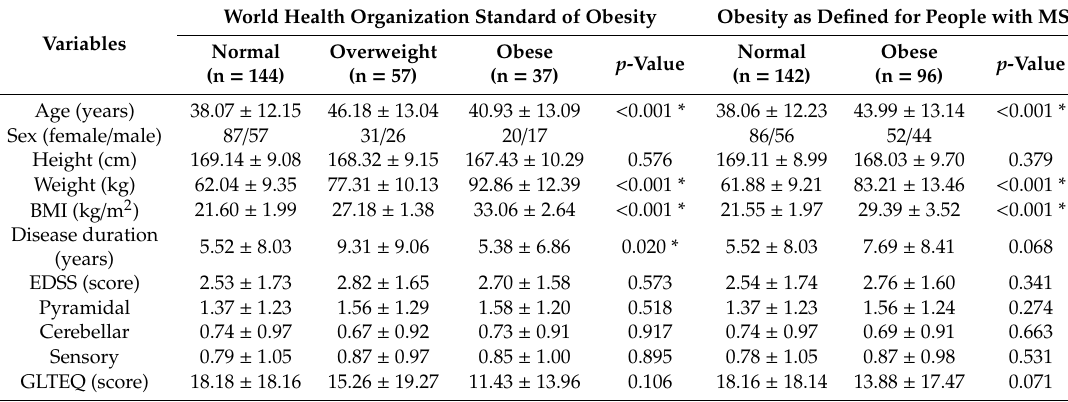
Table 1. Demographic and clinical characteristics of the study sample (n = 238).